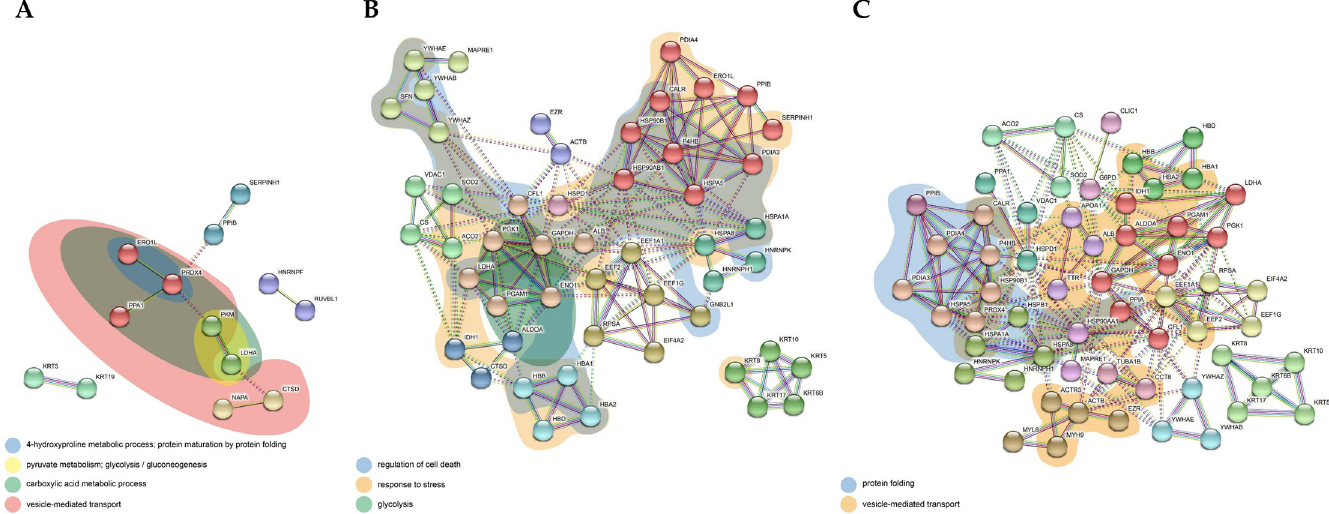
Fig 5. Protein-protein interaction network of differentially expressed proteins in (A) margin vs. center, (B) center vs. control, (C) margin vs. control comparison for SCC. The network nodes represent proteins while the edges represent predicted functional associations. There are 5 types of associations presented: neighborhood (green), experimental (purple), text mining (yellow), database (light blue), coexpression (black) evidence. The color of the nodes represents cluster membership. Inter- cluster edges are depicted by dashed lines. The colored areas represent functional